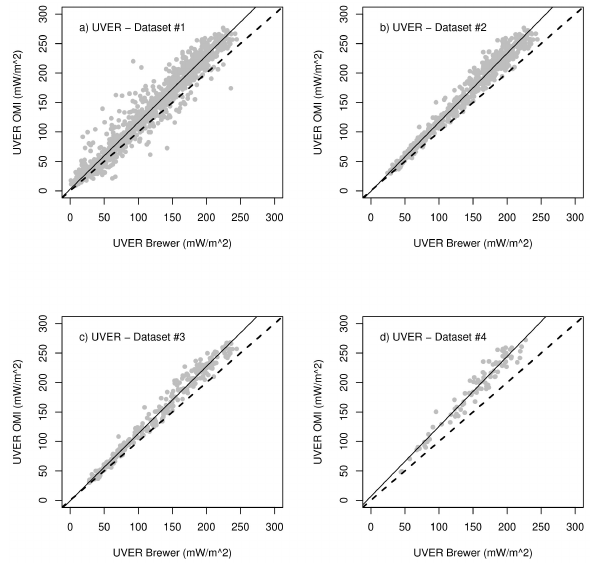
Figure 1 Fig. 1. (a) Correlation between OMI and Brewer UV products for all-sky conditions (dataset #1) for the UV irradiance weighted by the CIE spectrum (UVER); (b) for cloud-free sky condition or dataset #2; (c) dataset #3 and (d) dataset #4. The solid line is the least square linear regression line, and the dashed line symbolizes the ideal correlation of unit slope.